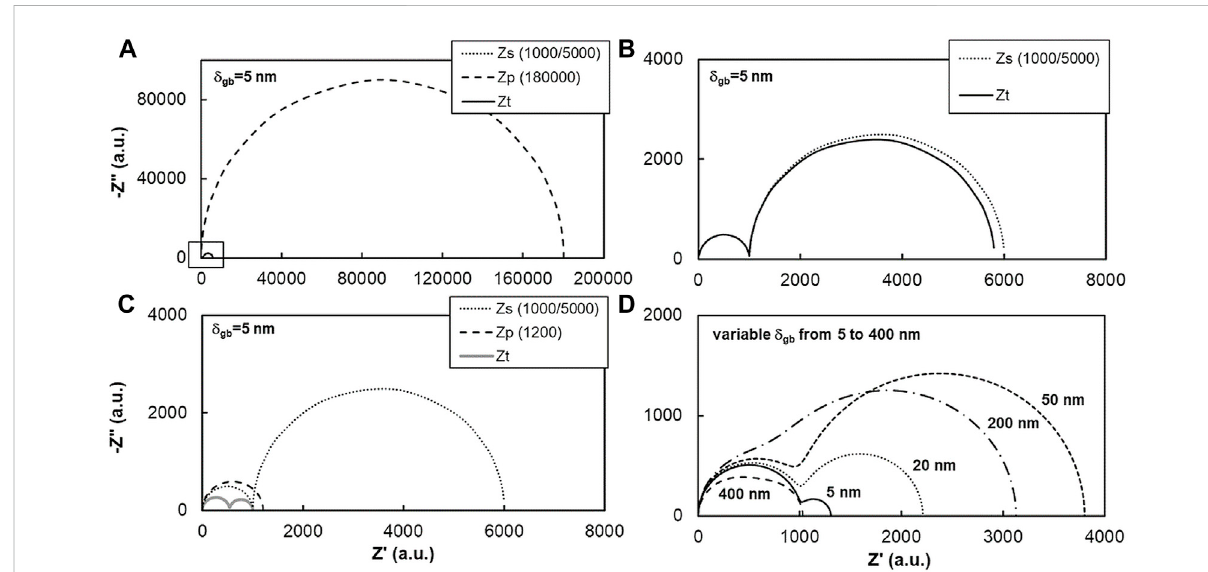
FIGURE 9 Simulated impedance spectra based on the equivalent circuit of Figure 8A, where Z s is the impedance of the series (bottom) circuit, Z p is the impedance of the parallel (upper) branch and Z t is the total impedance of the circuit. The spectra in Figures (A – C) were simulated with R b , R gb,s and R gb,p valuesgiven inthelegend, andD=1 µmand δ gb =5 nm.Spectrain (D) obtained assuming aconstraint ontheelectrical properties thatscale with a variable δ gb ( see text for